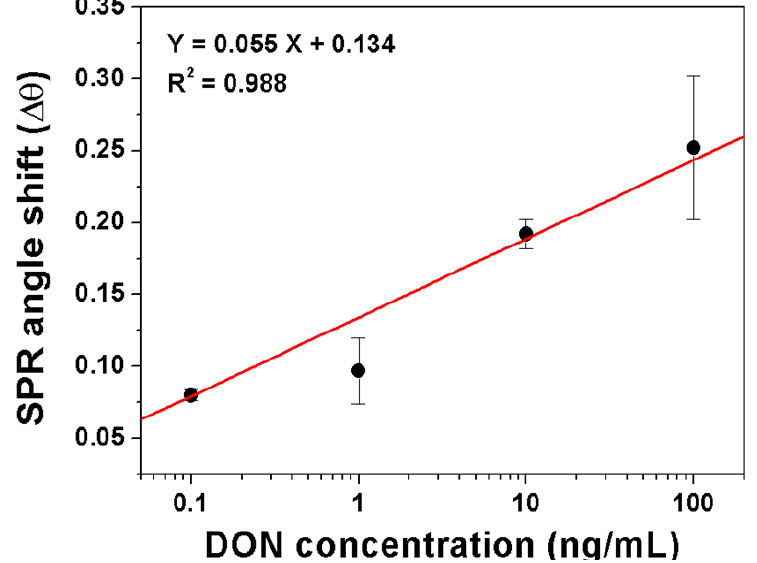
that molecular imprinting can be applied to the detection of DON. Figure 4. Resonance angle shift of DON–MIPPy chips according to varying concentrations of the DON solution. For DON measurement, at least, three different replications were